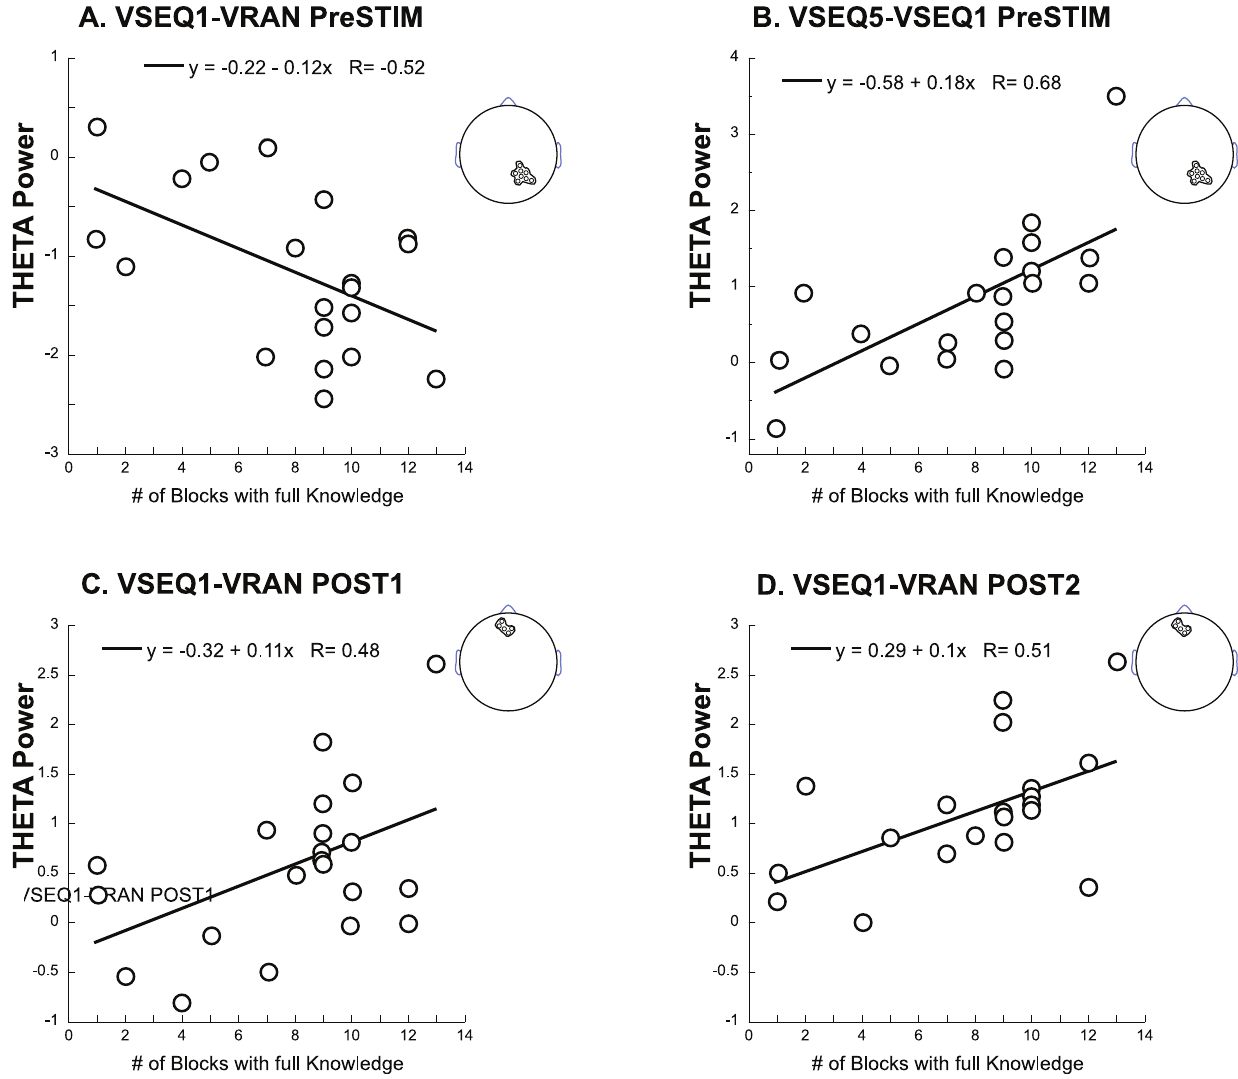
Figure 4. Correlation results. Scatter plots of the correlation between the number of blocks with full sequence order knowledge (i.e., learning indices) and changes in theta power in ROP (top, A. and B.) and AFr (bottom, C. and D.) during learning for time windows where significant power changes occurred. The five 250 ms temporal windows are defined in figure 3.